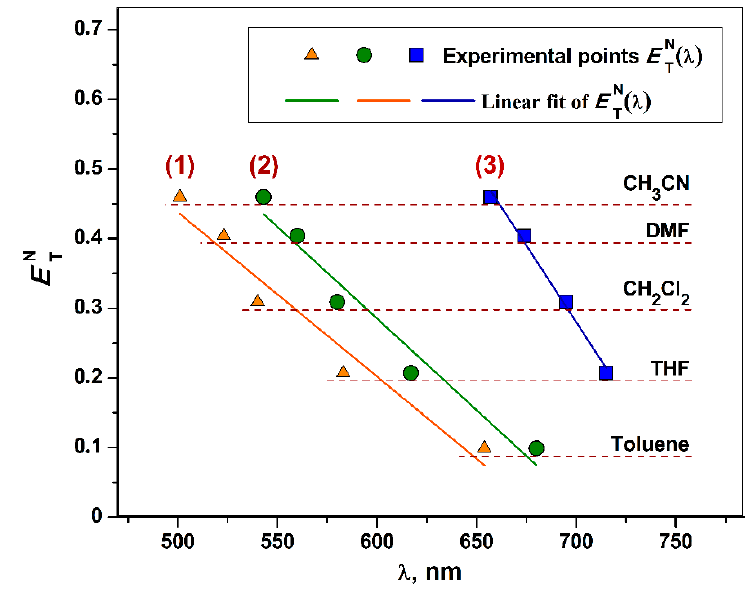
Figure 8. E TN ( λ ) dependences and linear fits for complexes 1 – 3 .